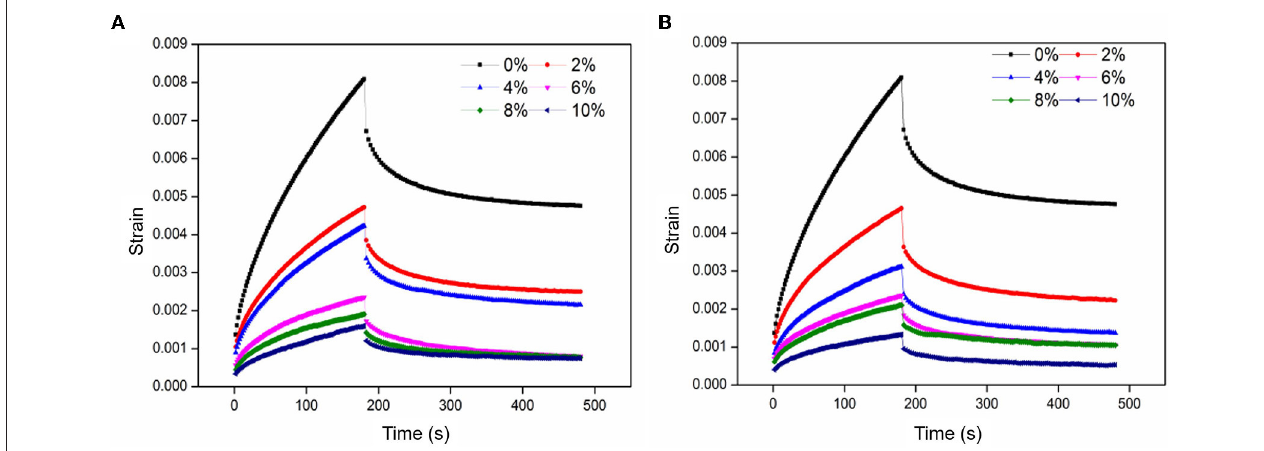
FIGURE 2 | Effect of UWBDF and FWBDF addition on the creep-recovery curve of dough: (A) dough with UWBDF and (B) dough with FWBDF.